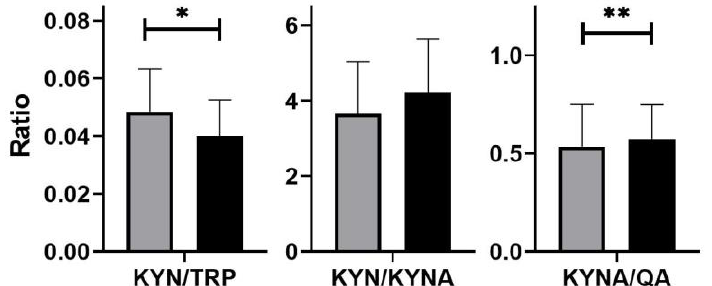
Figure 5. Ratios of tryptophan (TRP) and its metabolite levels (mg/gCr): kynurenine (KYN), kynurenic acid (KYNA), quinolinic acid (QA) in patients with small intestinal bacterial overgrowth before (grey) and after (black) rifaximin treatment. Differences were examined by Wilcoxon signed rank test; n = 40; * p < 0.05, ** p < 0.01.